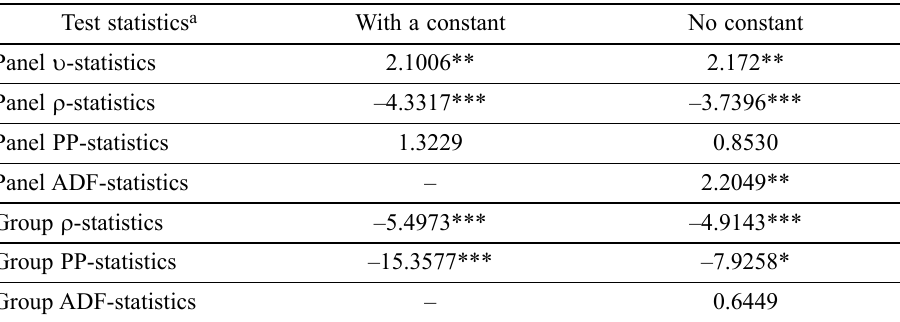
Table 4. Panel cointegration